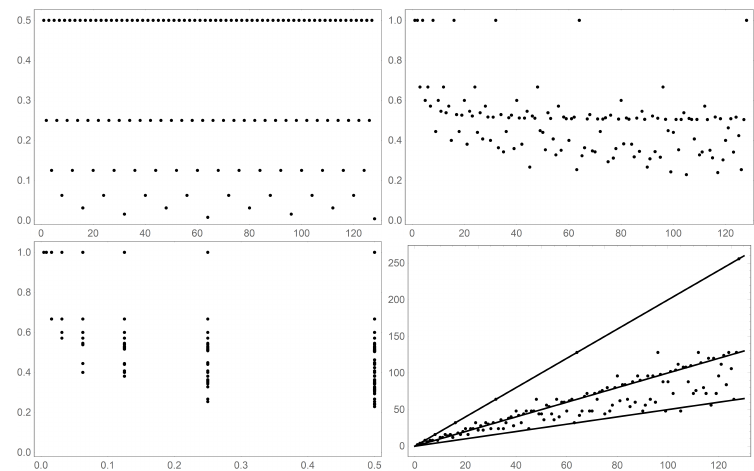
Figure 13. Several plots of data sets exposing some of the structure of the limit values of the centered polygonal lacunary sequences. These data are independent of k and thus hold for all centered polygonal lacunary functions at once. In all cases, the data are plotted as a function of p from p = 1 to 128 (the horizontal axis). The top left panel shows the unit cell size as a function of p from p = 1 to 128. The top right panel shows the saturation value versus p from p = 1 to 128. The bottom left panel shows the saturation as a function of unit cell size. The bottom right panel shows the number of fiber positions on the base